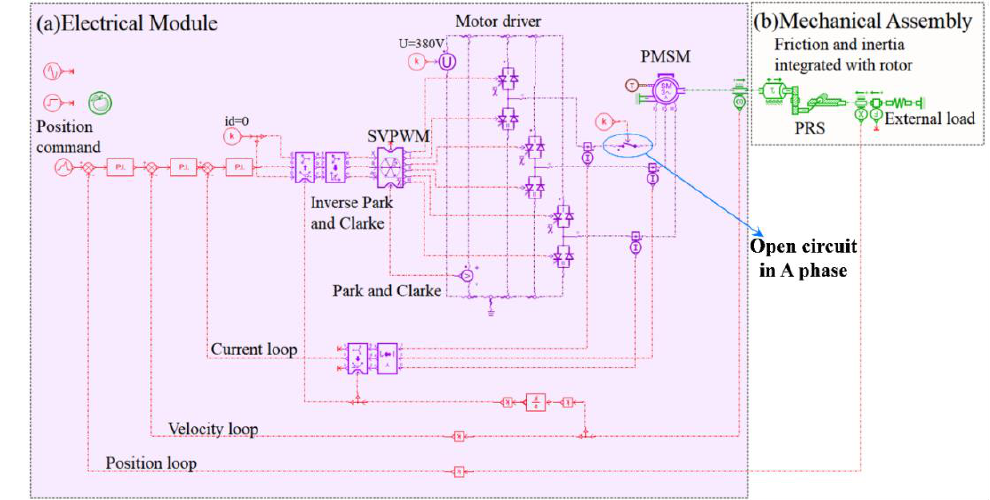
Figure 6. A-phase open circuit. A-phase open circuit represents 𝑖 𝐴 ≈ 0 and 𝑖 𝐵 + 𝑖 𝐶 = 0 .